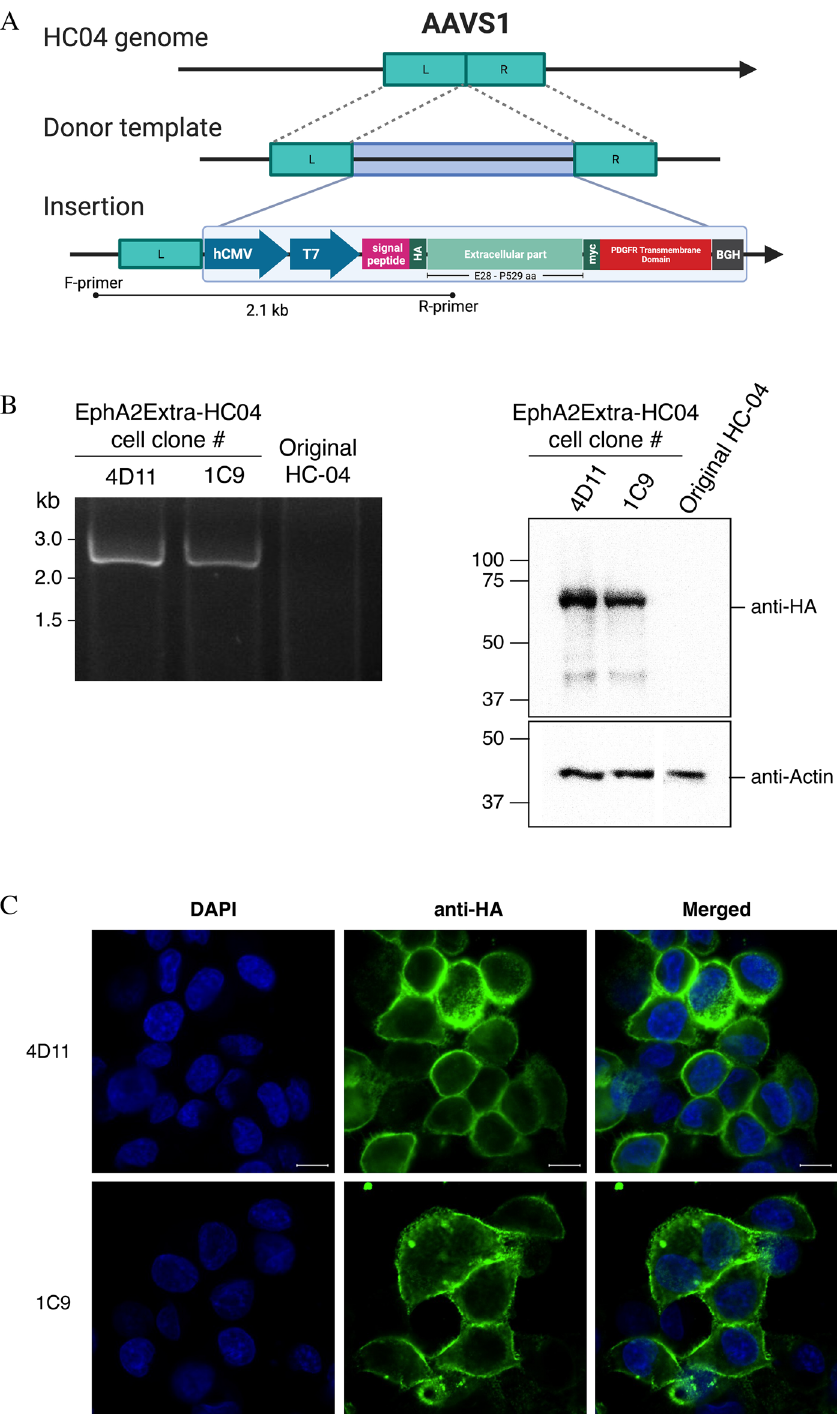
Figure 3. Generation of the transgenic EphA2Extra-HC04 cell line using a CRISPR-Cas9 knock-in approach. ( A ) Introduction of HA-Extra to the HC-04 genome by Cas9-mediated homology directed repair (HDR). Genome integration was induced by Cas9 with sgRNA targeting the AAVS1 sequence. Homologous recombination was achieved using a linear donor containing the HA-Extra cassette flanked by AAVS1 homology arms. The figure was created with BioRender.com. ( B ) Left: PCR demonstrating the presence of the HA-Extra sequence in two clones of the transgenic EphA2Extra-HC04 cell line. The forward primer binds to a sequence upstream of the left homology arm; the reverse primer binds to the ligand-binding domain (LBD) of the insert, resulting in a 2143-bp amplicon. Primer binding sites are depicted in ( A ). Right: Western blot analysis of the EphA2Extra-HC04 cell line. Total cell lysates were analyzed with the indicated antibodies. β-actin was used as the loading control. ( C ) Representative IFA images of EphA2Extra-HC04 clones expressing HA-Extra on the cell surface. HA-Extra was visualized with a HA-tag antibody. Nuclei were stained with DAPI. Scale bar: 10